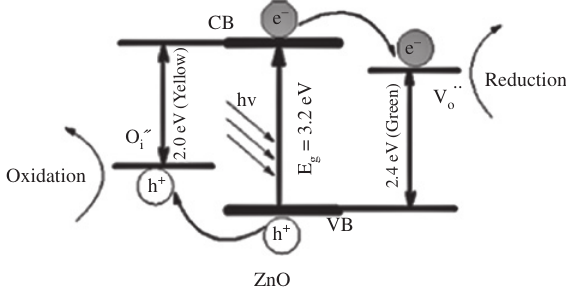
Figure 6: Band structure and charge transfer pathways of ZnO nanocrystal with oxygen defects